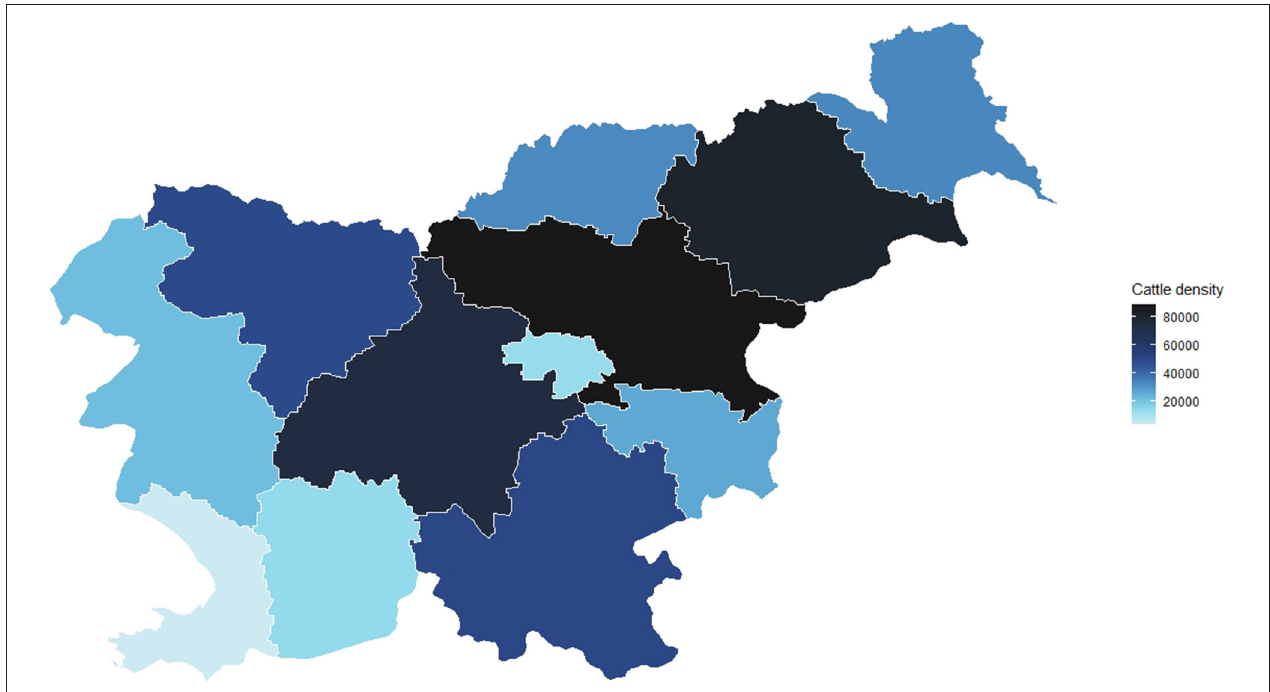
FIGURE 1 | Cattle density in Slovenia by statistical